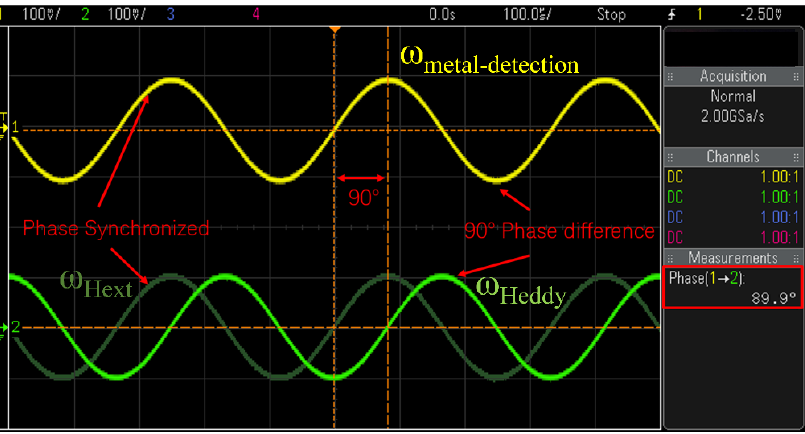
Figure 11. Simulation result of the phase difference between Colpitts oscillator and metal (clip).